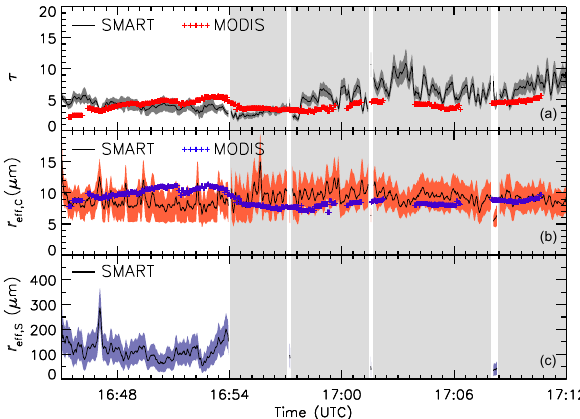
Figure 9. Same as Fig. 6 but for 17 May 2012. Non-shaded times in- dicate measurements above snow while for light-grey-shaded times the ocean was ice free.